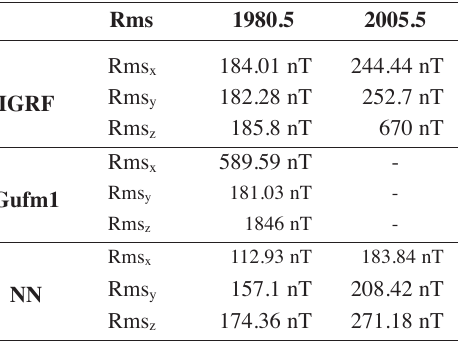
Table III. Deviation between values of observed components and respective values calculated by IGRF, Gufm1 and predicted by